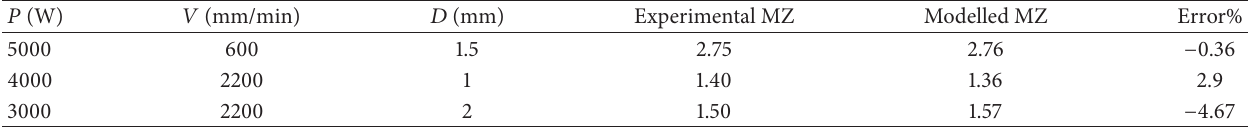
Table 7: Confirmation experiments—MZ.